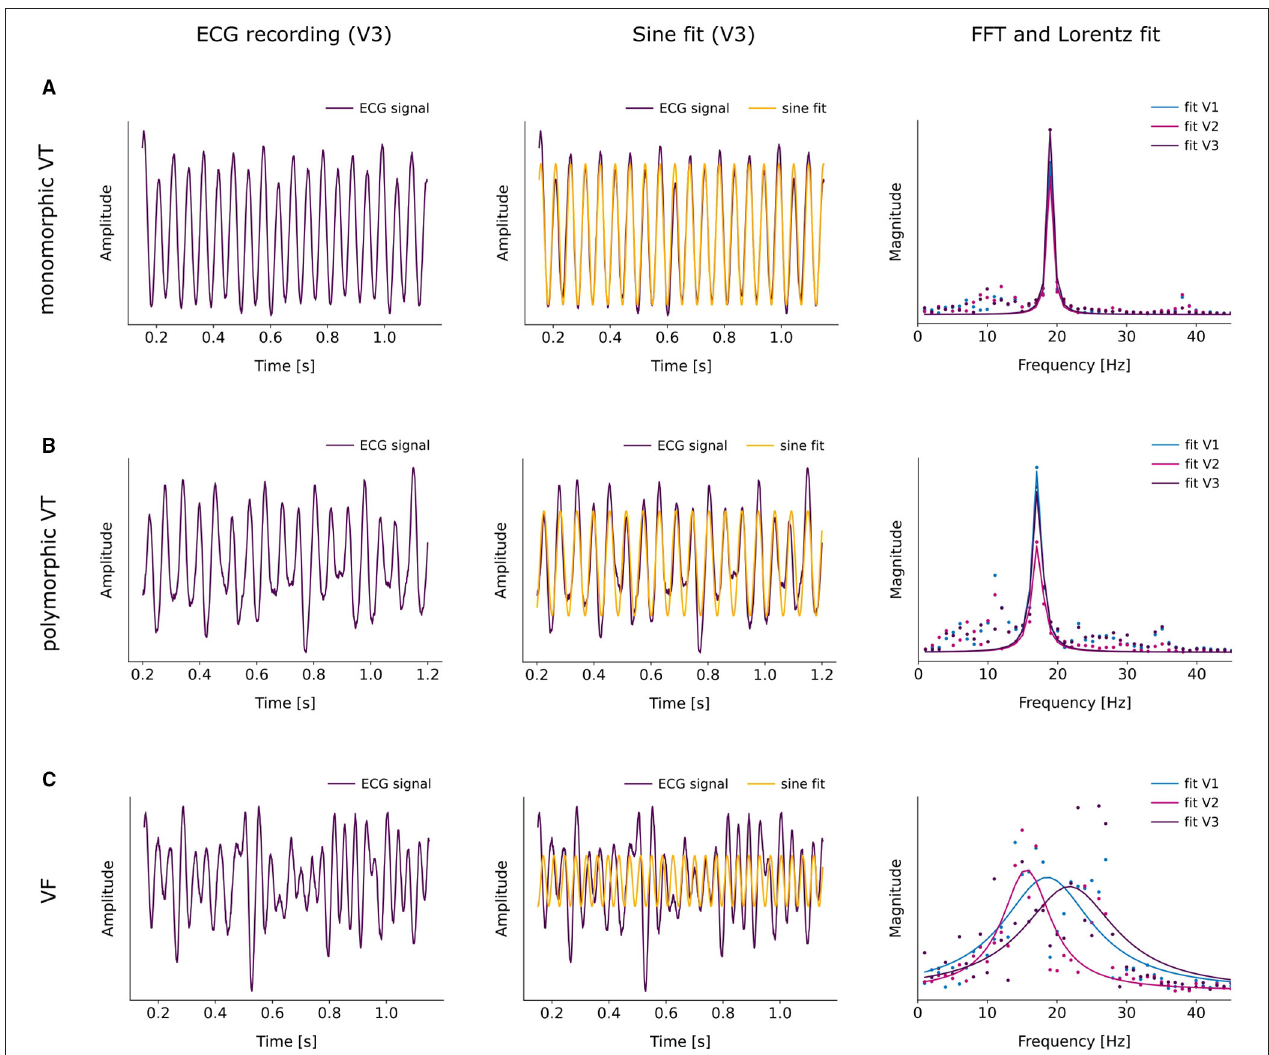
FIGURE 2 | Representative examples of the classification of the three arrhythmia types mVT (A) , pVT (B) and VF (C) . The left column shows the ECG recording acquired by electrode V3, the middle column displays the applied sine fit to the corresponding ECG signal and the right column illustrates the fitting of a Lorentzian function to the FFT of the ECG signal. (A) Example of a monomorphic VT. The sine fit results in a dominant frequency of f dom = (19.2 ± 0.5) ( gof = 0.8). The FFTs and Lorentzian fits of the three ECG signals of V1, V2 and V3 agree to a large extent. They yield the dominant frequencies f dom , V 1 = (19.0 ± 0.1) Hz and fwhm = (0.9 ± 0.1). (B) Example of a polymorphic VT. According to the sine fit, the dominant frequency of the arrhythmia lies at f dom = (17.3 ± 0.4) Hz with gof = 0.6. The Lorentzian fits to the FFT spectra result in f dom = (17.1 ± 0.1) Hz for all three ECG signals with slightly varying widths fwhm V 1 = (1.5 ± 0.2), fwhm V 2 = (1.8 ±